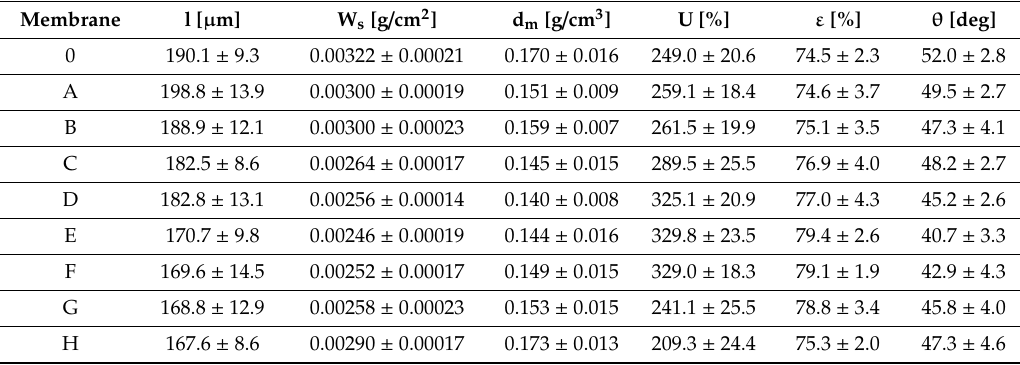
Table 2. Physicochemical properties of obtained